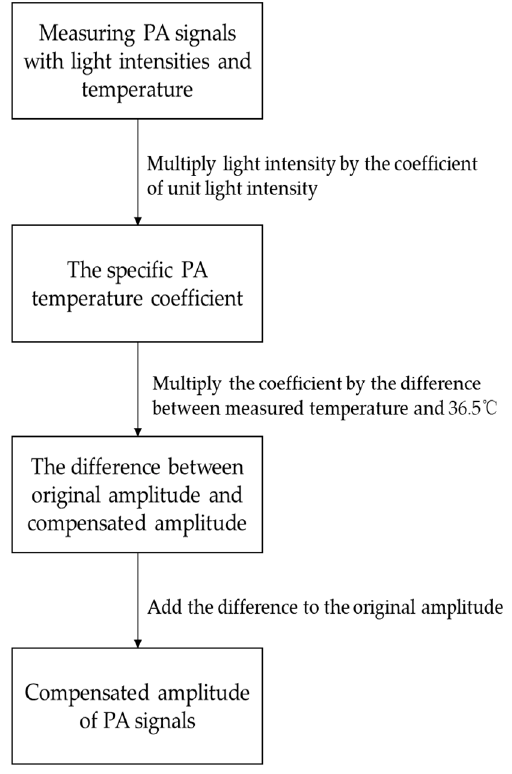
Figure 8. Flowchart of compensation.